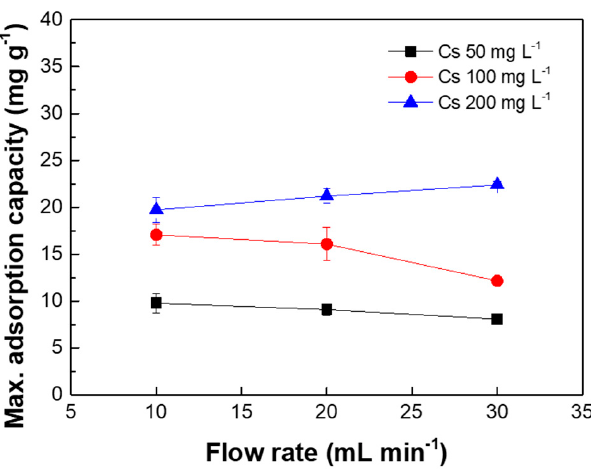
Figure 7. Maximum adsorption capacity of Cs + ions as a function of flow rate and influent concen- tration. Adsorption was conducted until the cell potential reached 1.2 V (Experimental conditions: Influent of pH 3 was fed for 60 min adsorption).